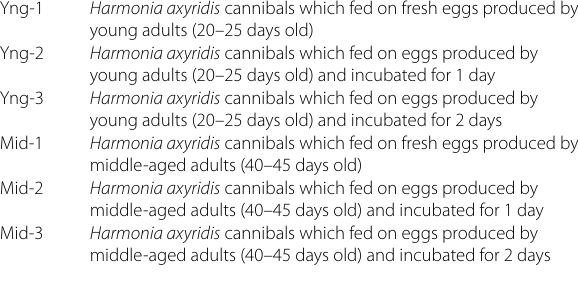
Asterisk in each row indicates a significant difference between the cannibal beetles and the control beetles ( p < 0.05), while ns means non-significant difference (p >